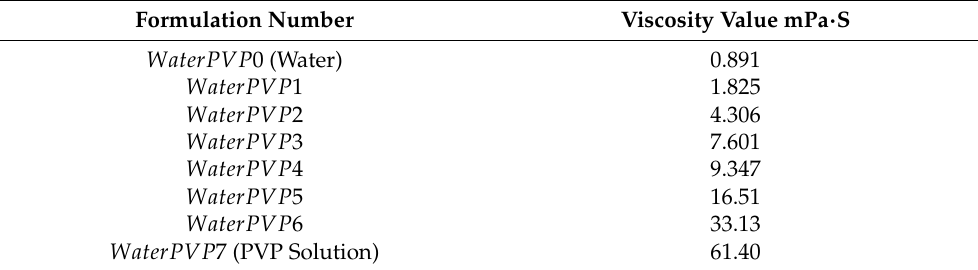
Table 2. Viscosity values of the different